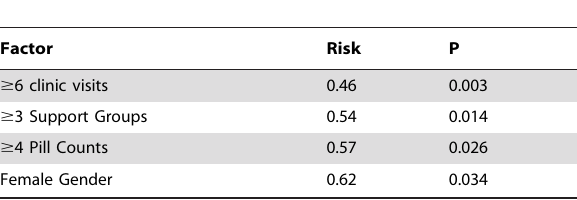
Table 3. Multivariate Analysis of Risk of